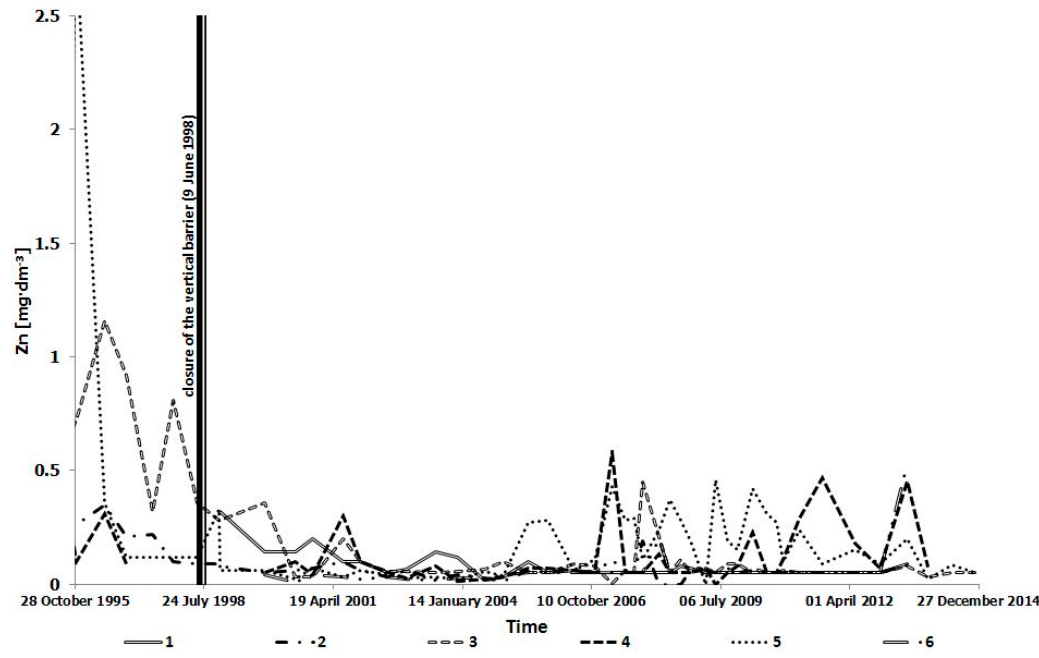
Figure 8. Changes of zinc concentration in groundwater on MSW Łubna Landfill surroundings during monitoring period 1994–2014.